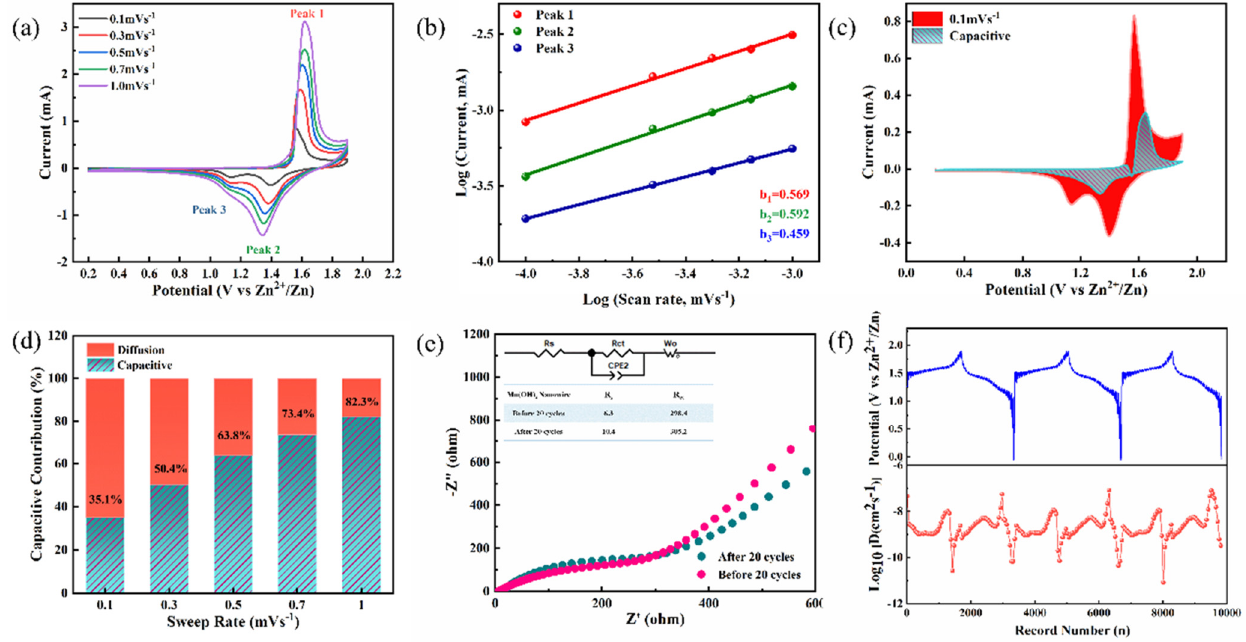
Figure 5. ( a ) CV curves at different scan rates. ( b ) ln(i) versus ln(v) plots at specific peak currents. ( c , d ) The contribution ratio of the capacitive capacities and diffusion-limited capacities under different scan rates. ( e ) Nyquist plot profiles and ( f ) charge–discharge GITT of Mn(OH) 2 //Zn ZIB.